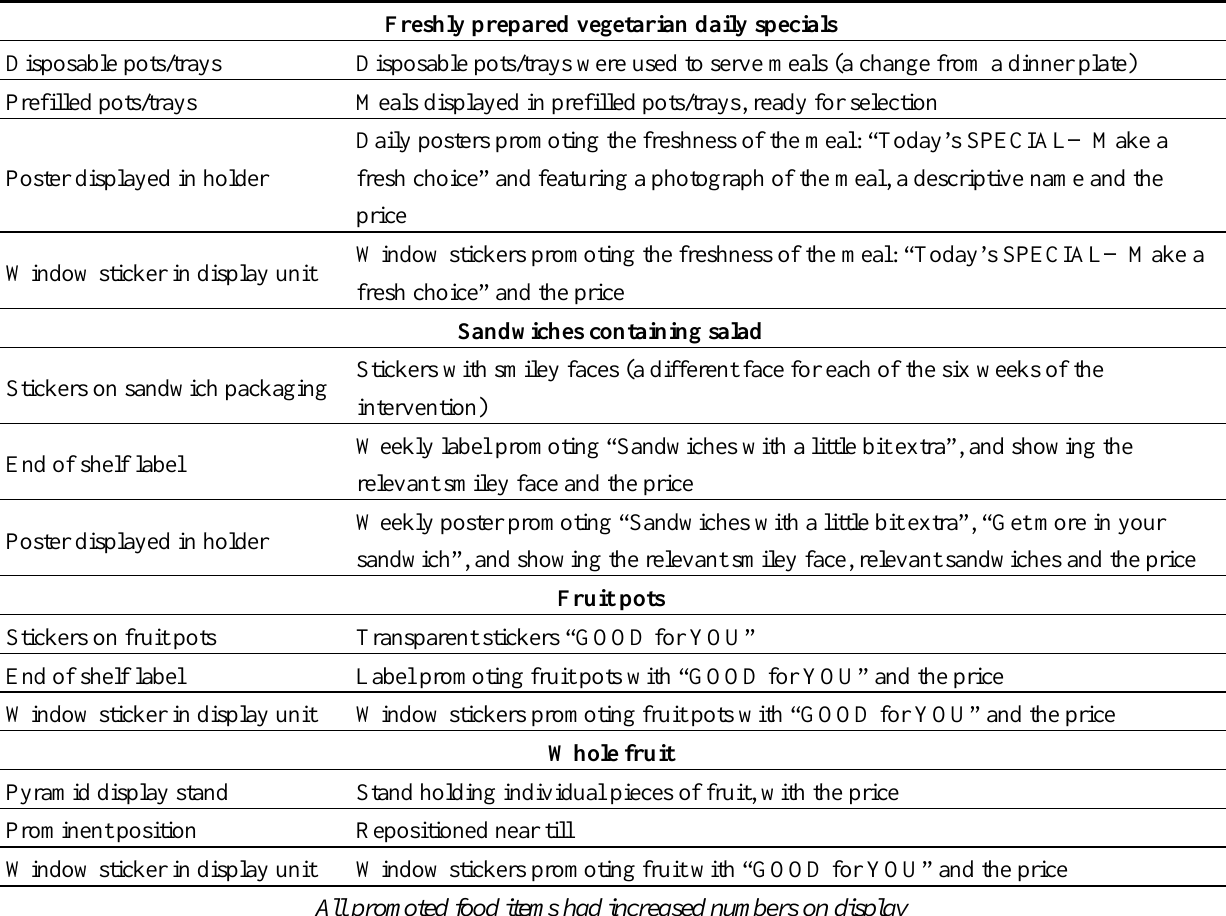
Table 1. Overview of the nudge strategies implemented for designated food